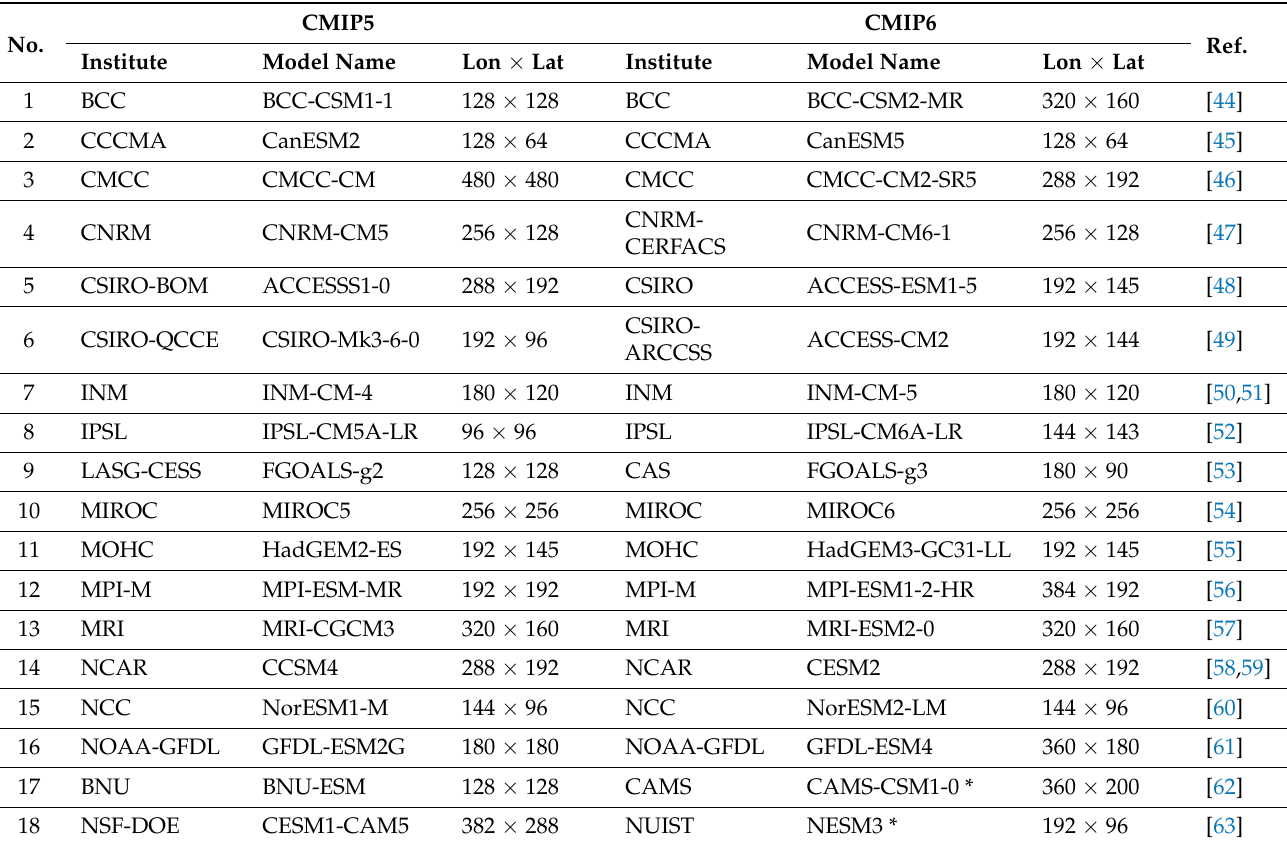
Table 1. List of global climate models (GCMs) in the CMIP6 and their previous version in the